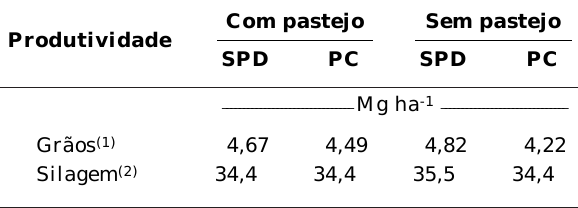
Quadro 3. Produtividade de grãos e silagem em solo sob plantio direto (SPD) e convencional (PC) com e sem pastejo